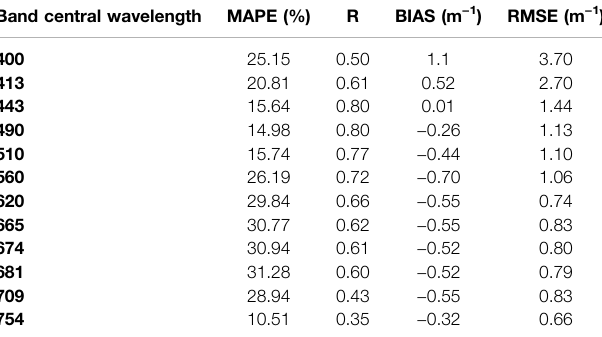
TABLE 2 | Statistical results of α t ( λ ) retrieval for OLCI